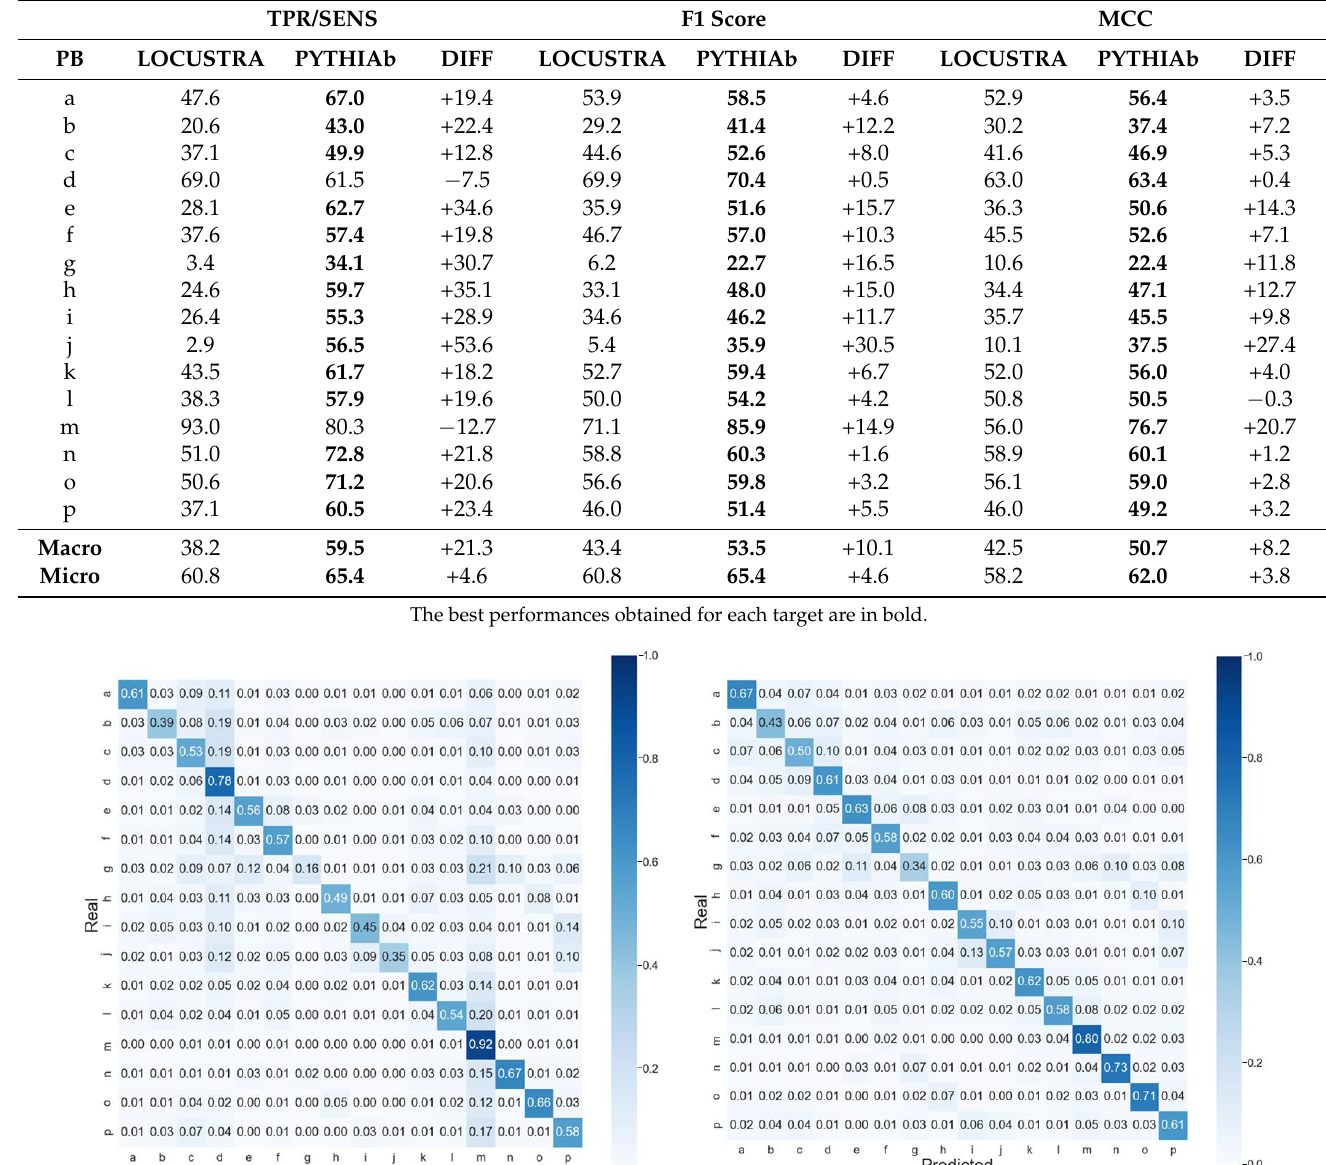
Table 2. Evaluation of the performances of the balanced accuracy PYTHIA model compared to the LOCUSTRA reference method. Several statistical measures were used: true positive rate (TPR), F1-score, and Matthew (cid:48) s correlation coefficient (MCC). The DIFF columns in green represent the gain of performances in favor of PYTHIA and in red, in favor of LOCUSTRA. The width of bars is scaled according to the highest value of the corresponding metric. We present two metrics for average: “macro” average (averaging the unweighted mean per class) and “micro” average (averaging the total of the true positives, false negatives, and false positives). The micro average of TPR corresponds to Q 16 .